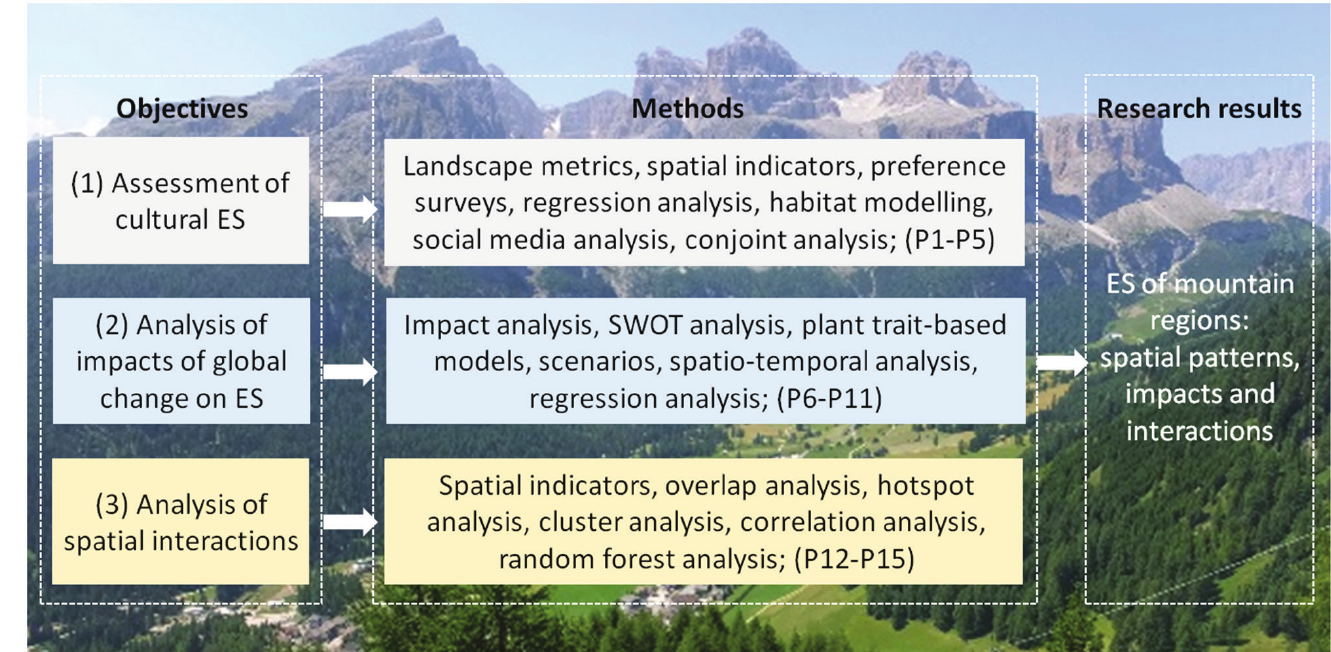
Figure 1. Three sub-objectives and applied methods to analyse spatial patterns, impacts and interactions of ES in the European Alps. Related publications (P) are indicated by